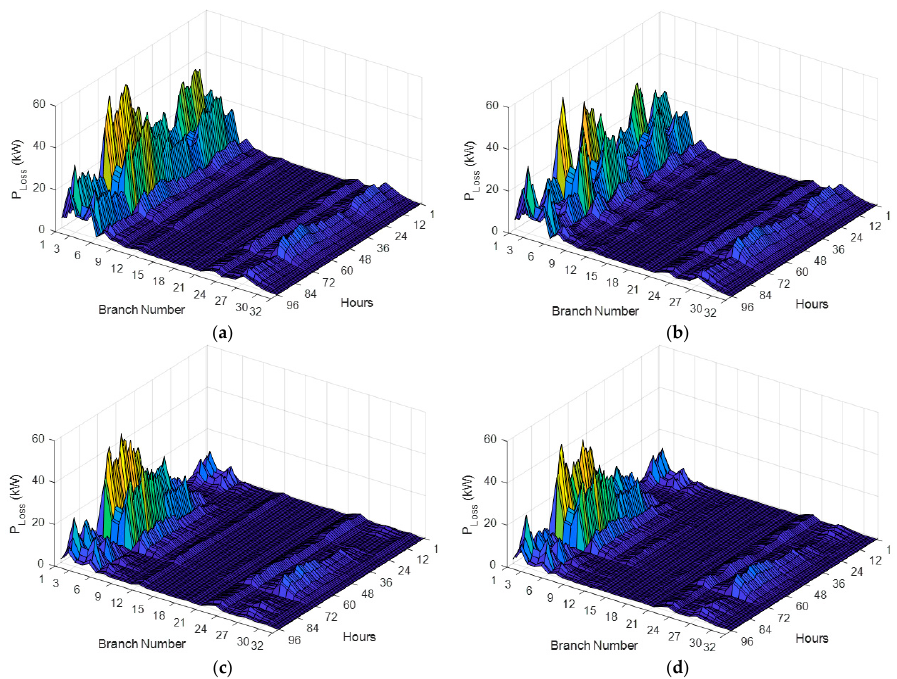
Figure 11. Seasonal branch active power loss variation for the IEEE 33-bus: ( a ) Basic case; ( b ) PVDG case; ( c ) WTDG case; ( d ) Hybrid PVDG-WTDG case.